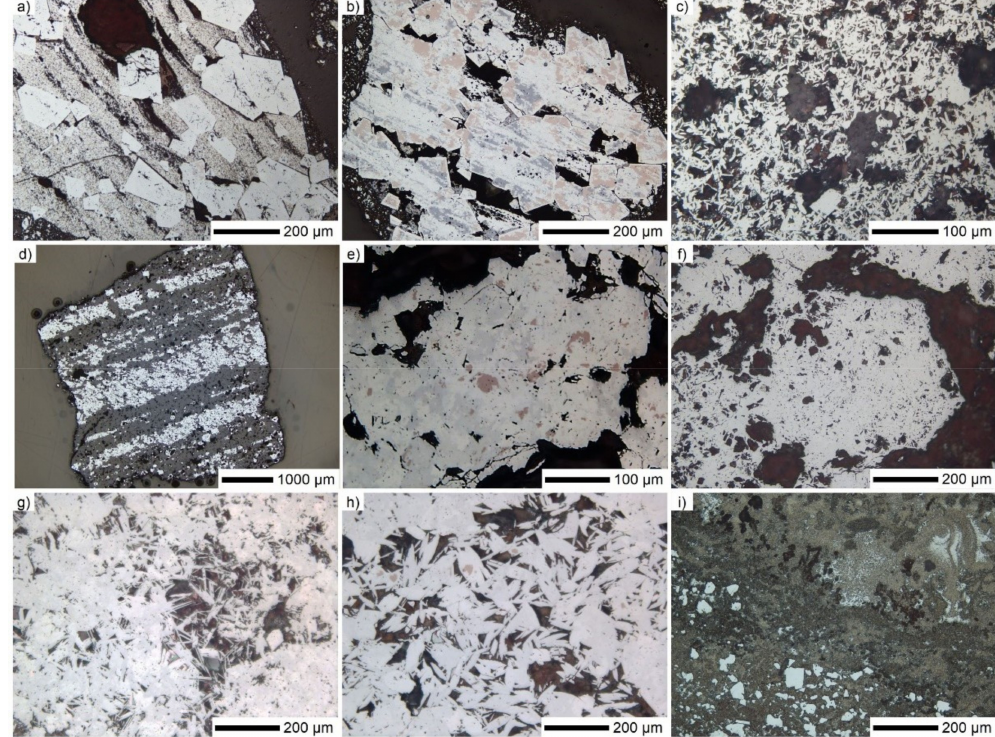
Figure 4. Reflected light micrographs of iron ores: ( a – c ) Caraj á s, ( d – f ) Sukha Balka, and ( g – i )